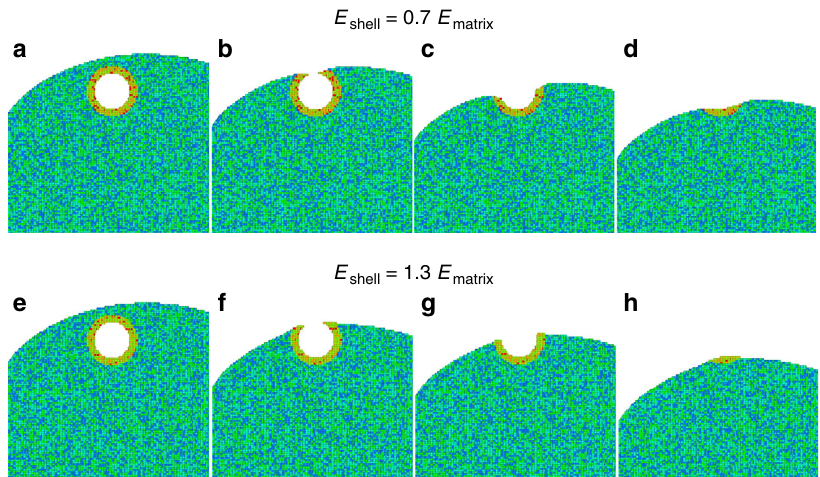
Fig. 5 Cross-sectional snapshots of the simulated tip at different evaporation stages of the nanovoid. a – d and e – f show the lower and higher fi eld shell cases, respectively. The atoms in the matrix are colored in blue and dark green, whereas atoms in the shell are colored in red, yellow and